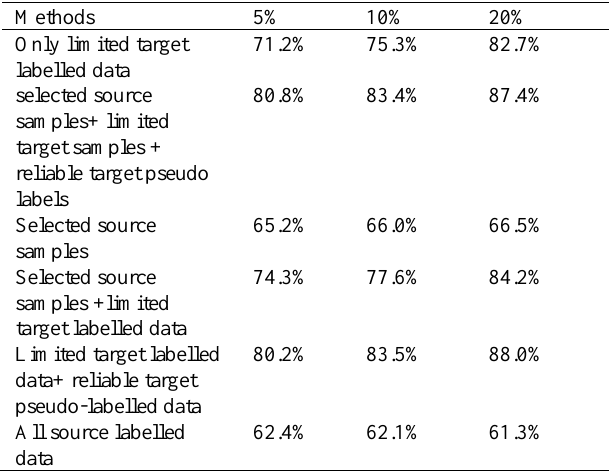
Table 1. The classification accuracy under different training ratios when using VGG-16